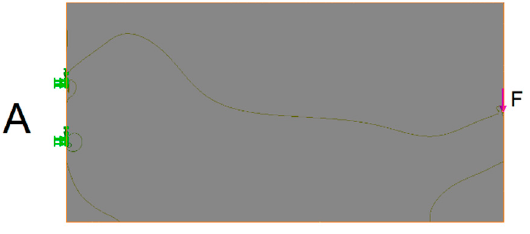
Figure 9. Direction of the principal compressive stresses in the basic beam.